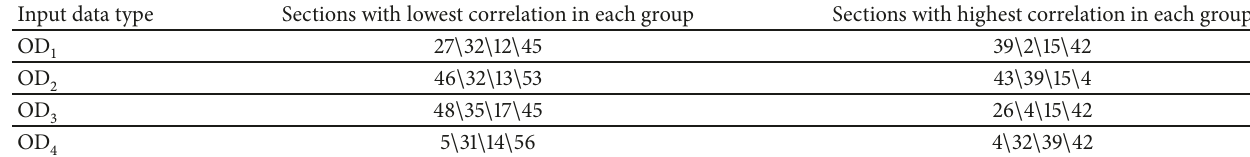
Table 1: Correlation analysis based on grouping